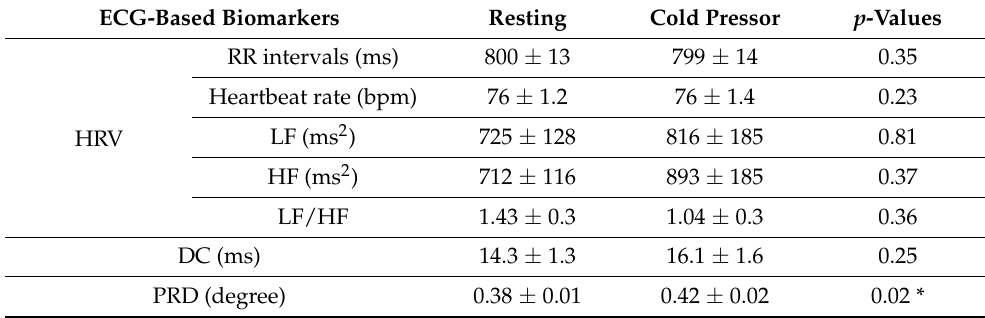
Table 1. The ECG-based cardiac function biomarkers in resting and cold pressor conditions. ECG-Based Biomarkers